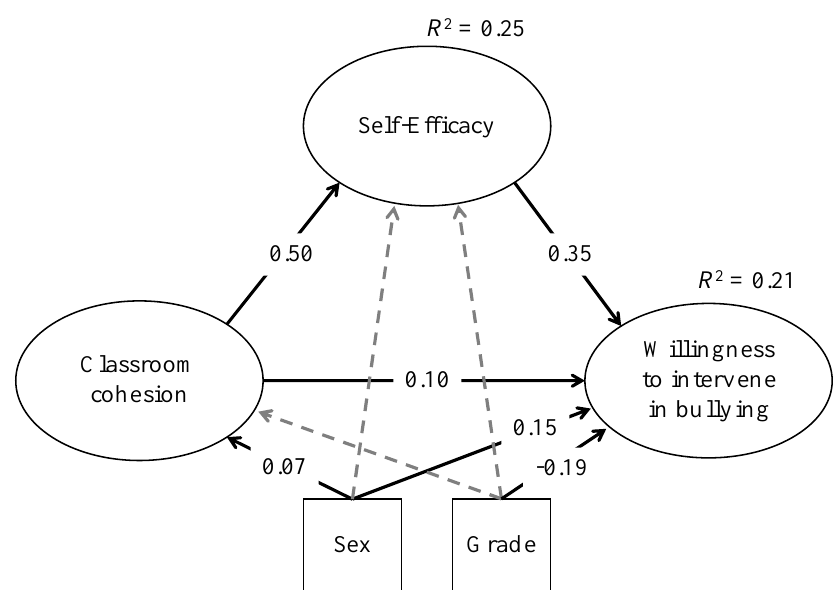
Figure 1. Direct and indirect effects of the latent variables classroom cohesion, self-efficacy, control variables, and willingness to intervene in bullying. Notes: Dash arrows—non-significant path coefficients.